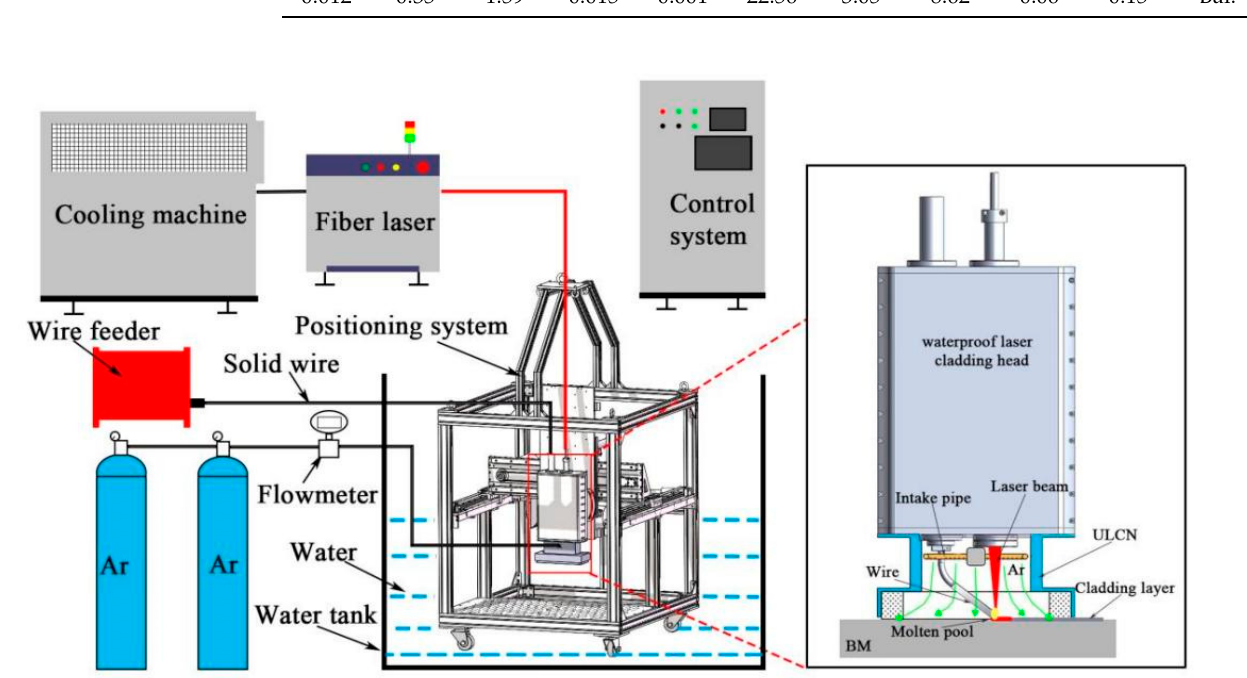
Figure 1. Schematic of underwater laser cladding system.